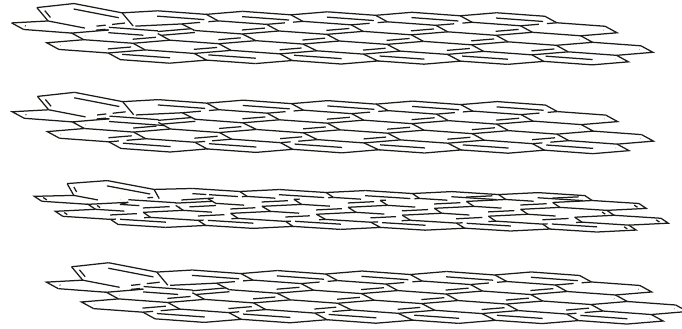
Figure 10: Structure and morphology of